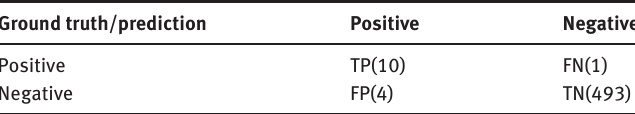
Table 3: Confusion Matrix. Ground truth/prediction Positive Negative Positive TP(10) FN(1) Negative FP(4) TN(493) True positive (TP), true detections correctly classified; false negative (FN), true detections that were incorrectly classified as false; false positive (FP), false detections that were incorrectly classified as true; true negative (TN), false detections correctly classified.